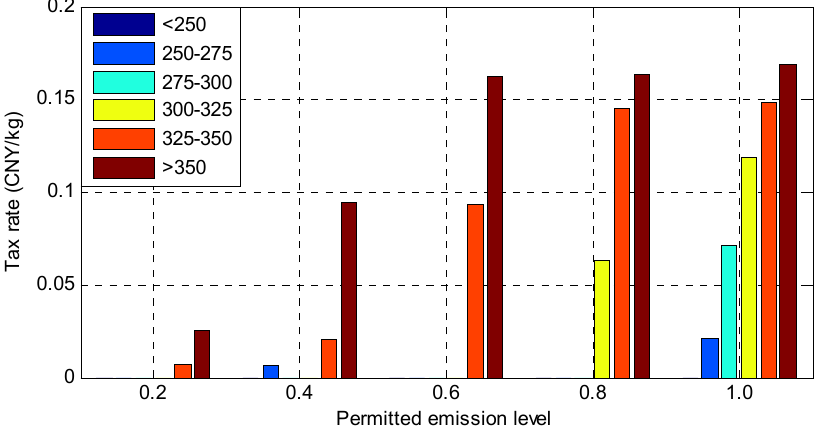
Figure 3. Weighted average tax rate of each group under different emission level.